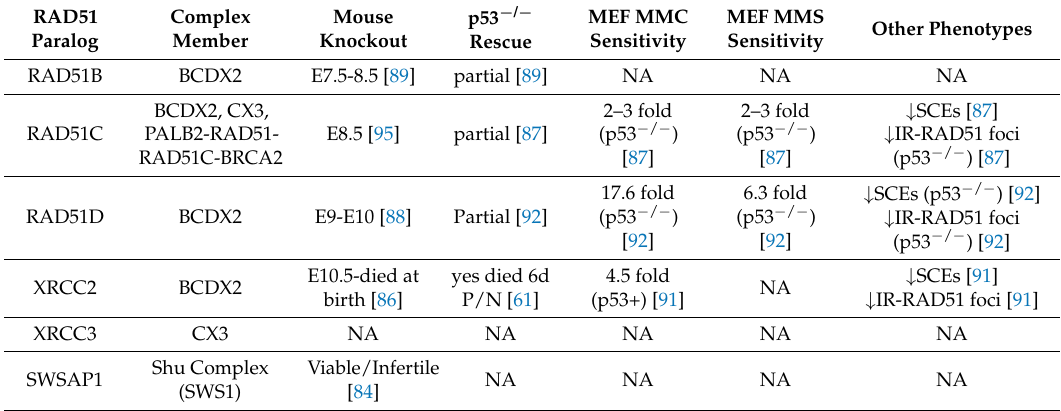
Table 2. RAD51 paralog knockout mice and derived mouse embryonic fibroblast (MEF) phenotypes. RAD51